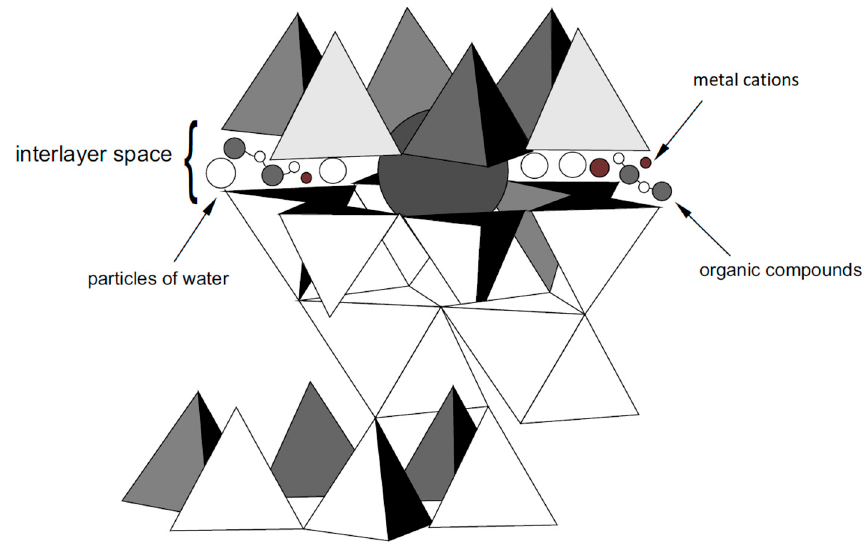
Figure 15. Modification scheme of the clay internal structure allowing sorption of heavy metals and organic compounds by K. Bahranowski, 2000 [29].